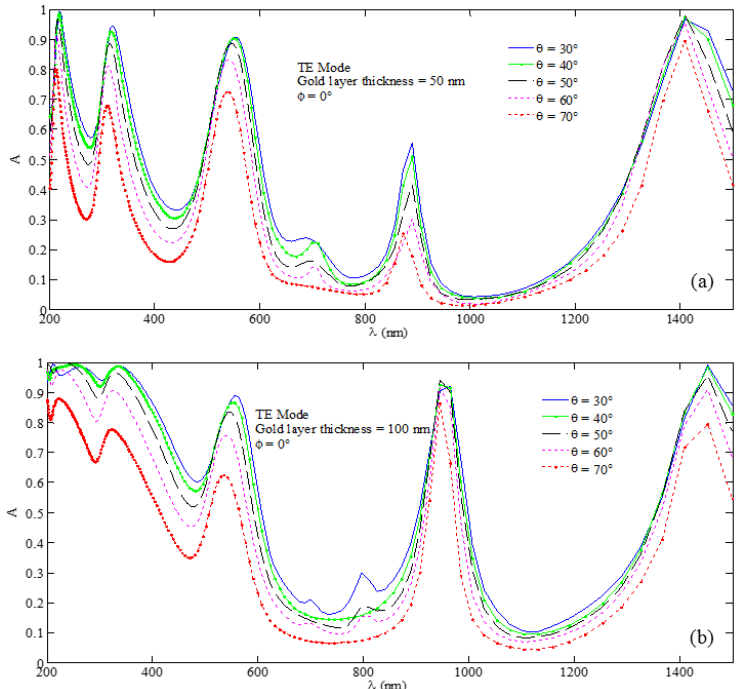
Figure 3. Absorption spectra for the butt-facing U-shaped MPA nanostructure under the TE wave excitation with ϕ = 0° incidence and corresponding to the cases of ( a ) 𝑑 = 50 nm and ( b ) 𝑑 = 100 nm with 𝑡 = 100 nm.